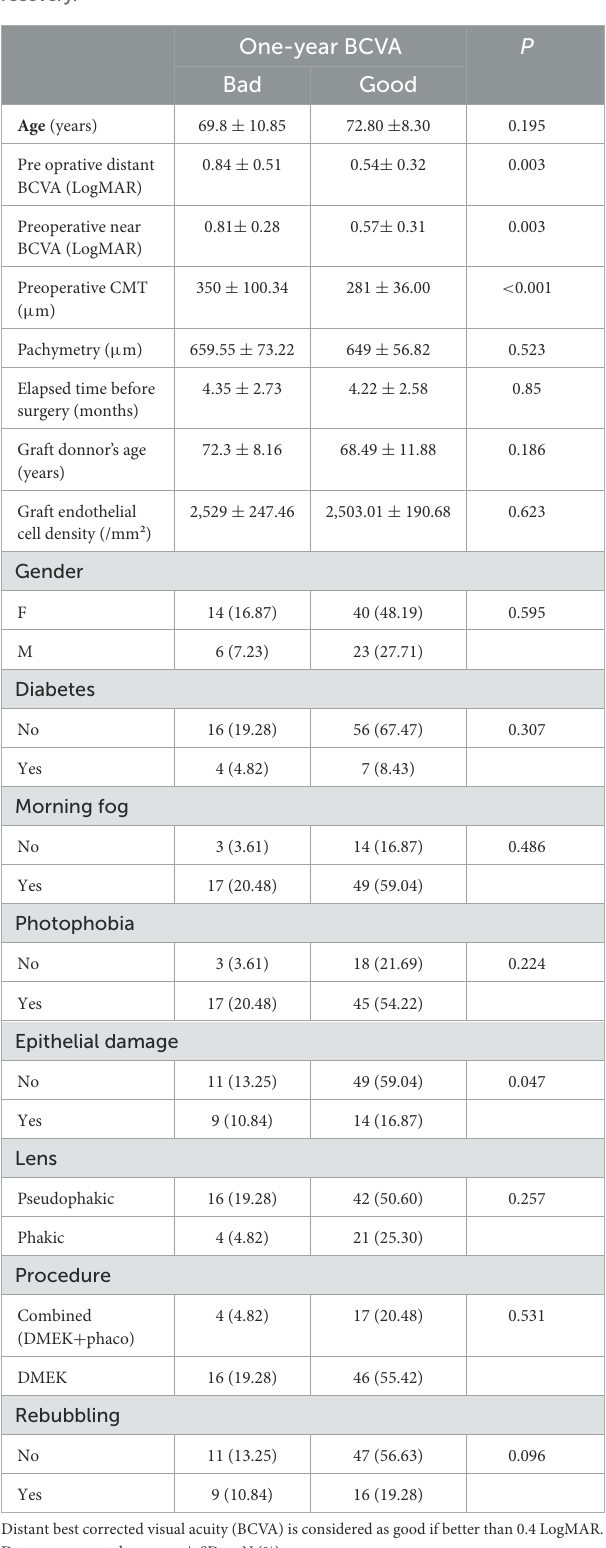
TABLE 2 Univariate analysis of predictive factors for long-term visual recovery.